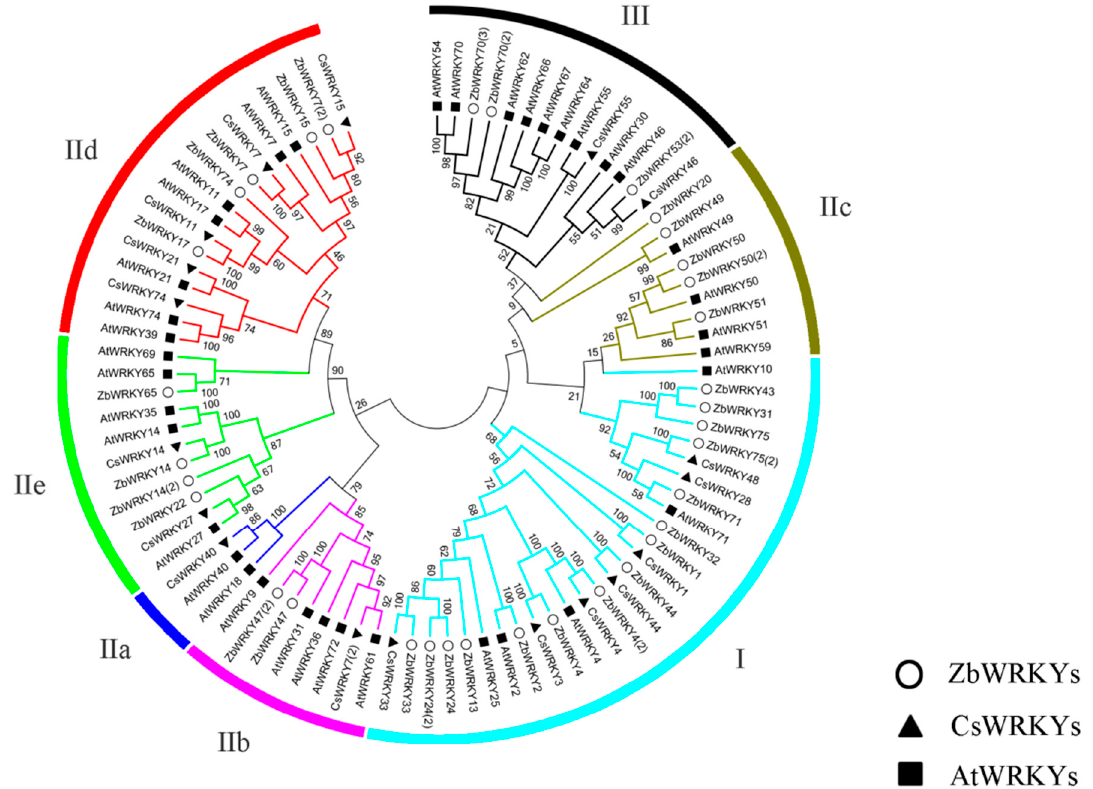
Figure 1. Phylogenetic tree of the WRKY protein.